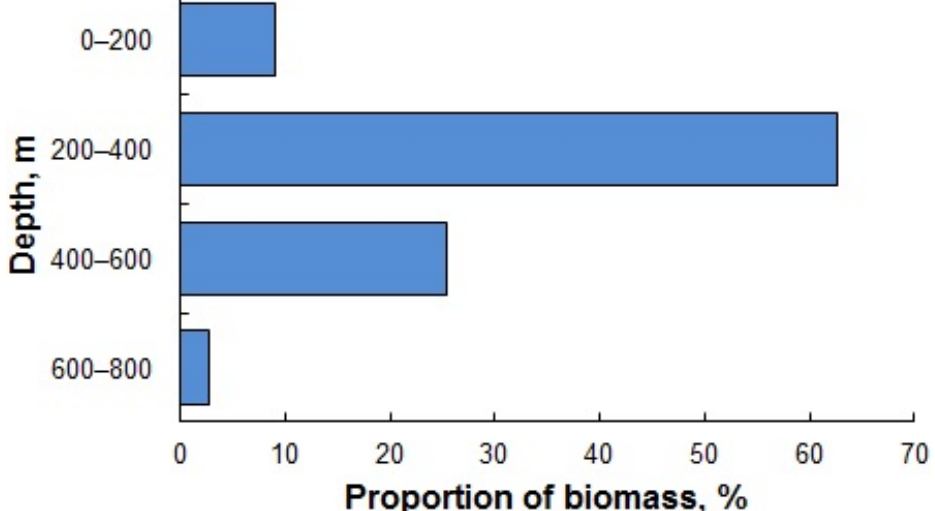
Figure 6. The proportional biomass of ice cod Arctogadus glacialis with depth of sampling across fjord and shelf stations in Northeast Greenland (cf. Table 1 and Figures 1 and 3).